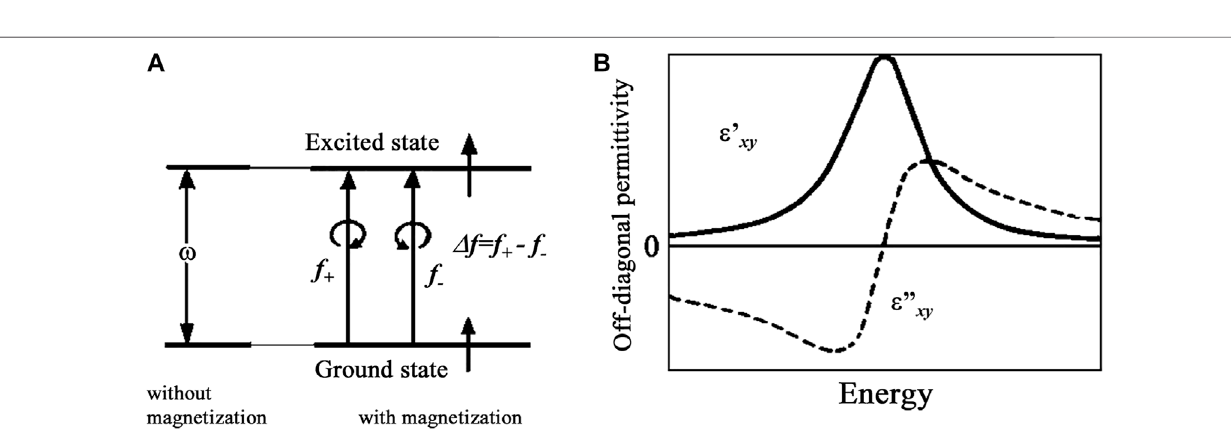
Frontiers in Physics |